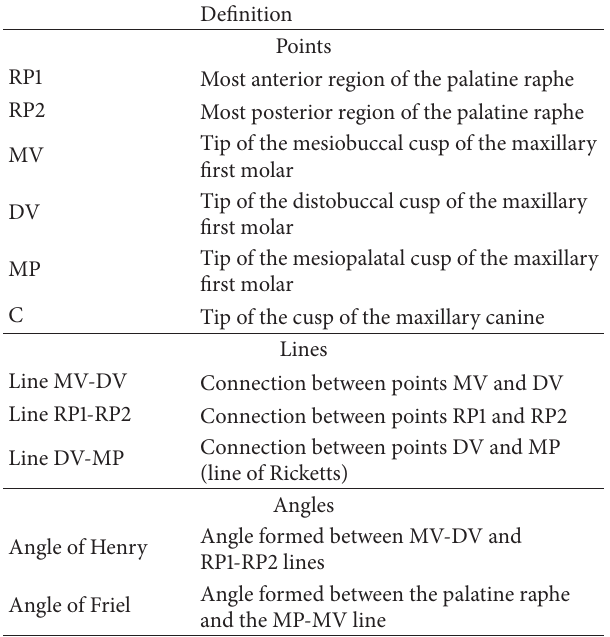
Table 1: Points, lines, and angles used to evaluate molar rotation. Table 2: Mean, standard deviation, statistical significance, and error for assessment of interexaminer